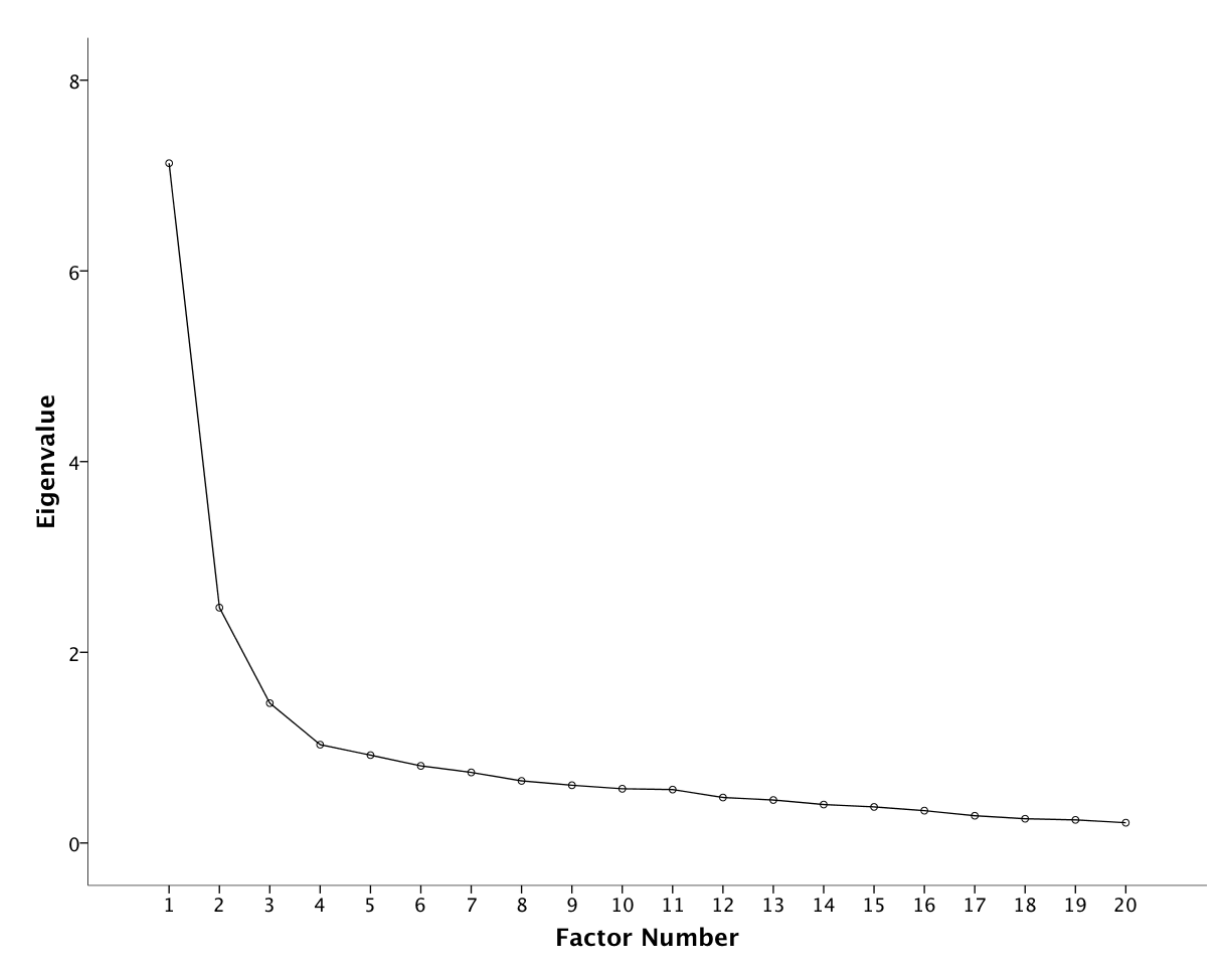
Figure 3. Scree plot for the factor analysis.